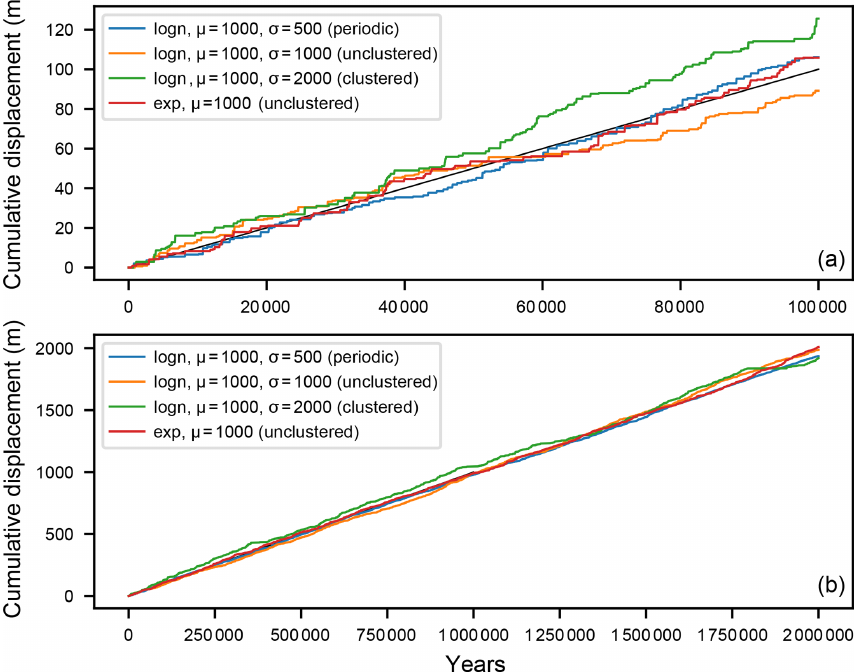
Figure 4. Simulated displacement histories for each of the recurrence distributions, and the “true” mean line at 1mmyear − 1 in black; (a) the first 100000 years; (b) the entire 2000000 years. The histories are the same in both